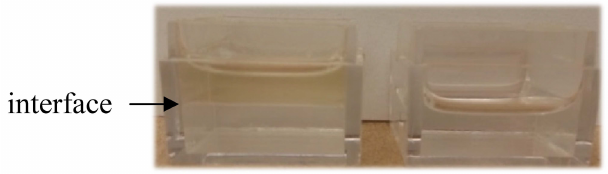
Figure 4. On the left is the fluid chamber (20 × 20 × 15 mm ) showing the fluid interface between oil (top layer) and a sodium chloride/sodium bicarbonate solution (bottom layer) that comprises the microrobot’s planar work surface. On the right is the concave meniscus that occurs without the oil